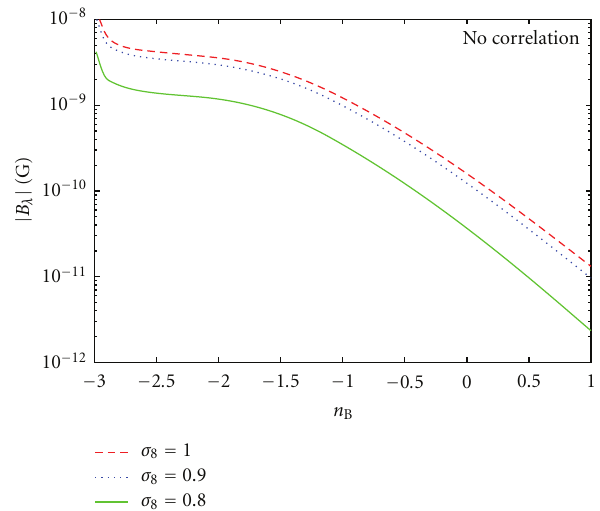
Table 1: PMF parameters and Λ CDM model parameters and 68% confidence intervals ( A t /A s is a 95% CL) from a fit to the